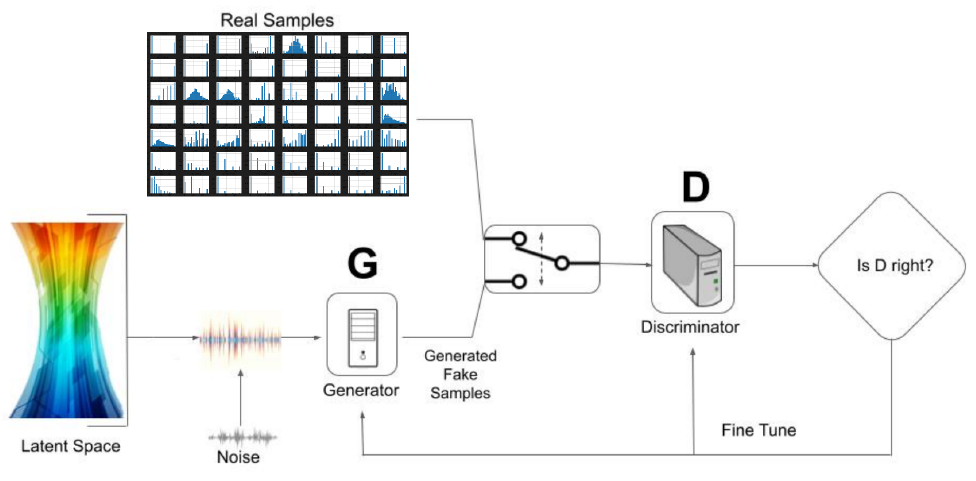
Figure 1. Structure of a Generative Adversarial Network model